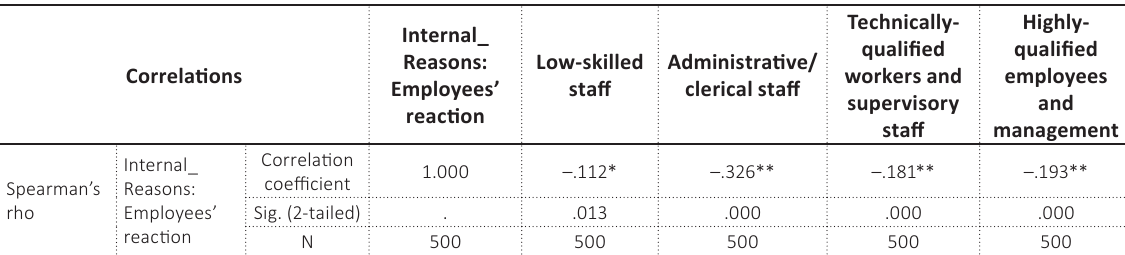
Source: Own research (SPSS